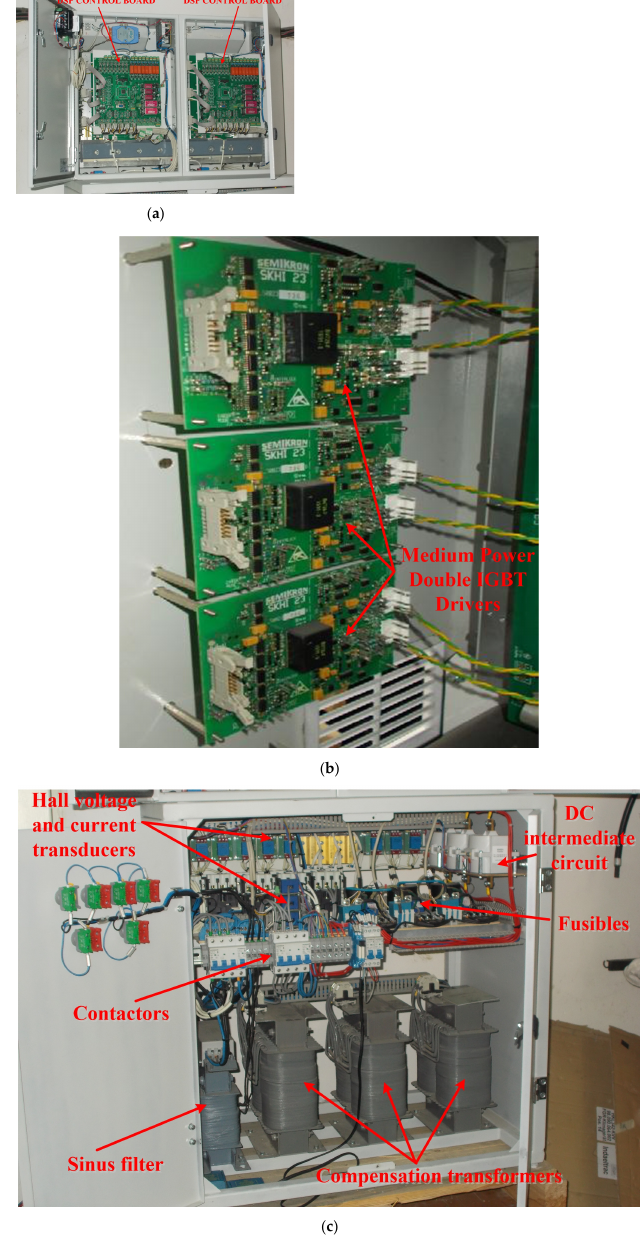
Figure A1. UPQC system hardware implementation: ( a ) Active series filter and APF DSP control boards; ( b ) Power active elements–double driver circuit for medium power IGBTs; ( c ) Power circuit components.